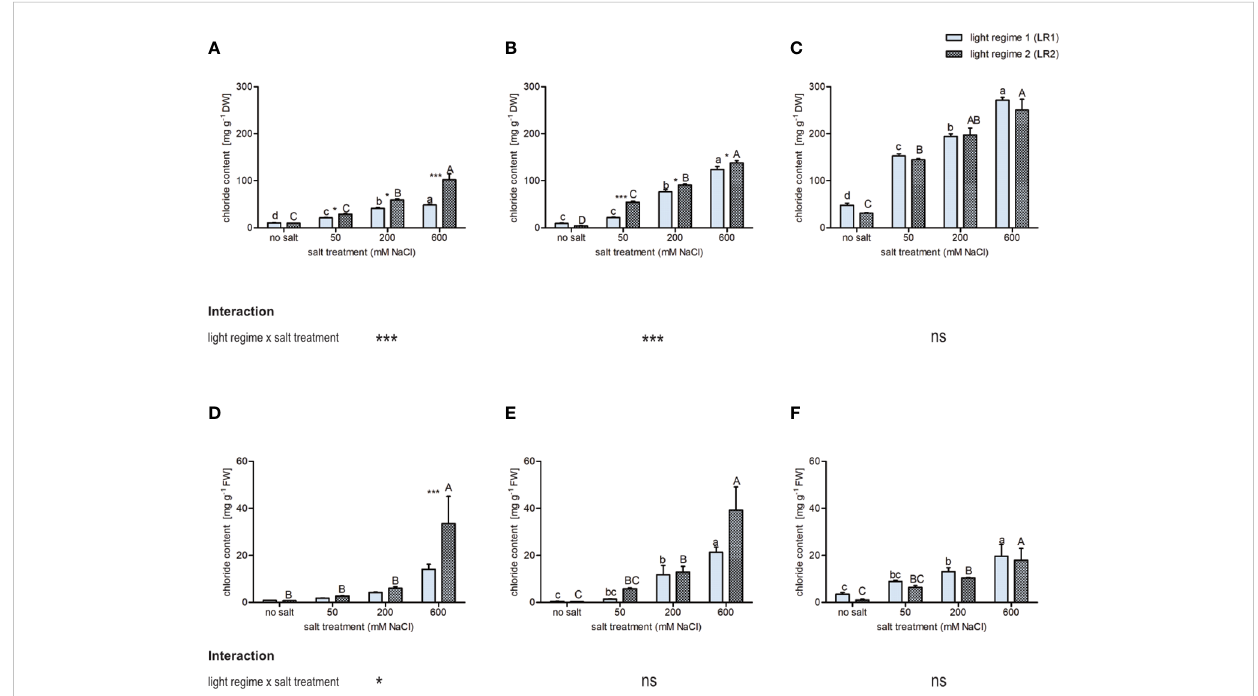
FIGURE 2 In fl uence of salt treatment and light regime on chloride concentration on (A – C) dry mass basis and (D – F) fresh mass basis in the leaves of 6- to 9- week-old plants. (A, D) Cochlearia of fi cinalis ; (B, E) Atriplex hortensis ; (C, F) Salicornia europaea . Bar represents means ± SEM of n = 8 pools of three individual plants each from two independent experiments. Small letters indicate signi fi cant differences between salt treatments in light regime 1 (LR1, greenhouse) in alphabetical order from highest to lowest; capital letters indicate signi fi cant differences between salt treatments in light regime 2 (LR2, indoor farming) in alphabetical order from highest to lowest; asterisks indicate signi fi cant differences between LR1 and LR2 in between one salt treatment; interaction shows signi fi cantly different interactions between salt treatments and light regimes tested by two-way ANOVA, followed by post-hoc Bonferroni test ( p ≤ 0.05) (* ≤ 0.05, *** ≤ 0.001); ns, not signi fi